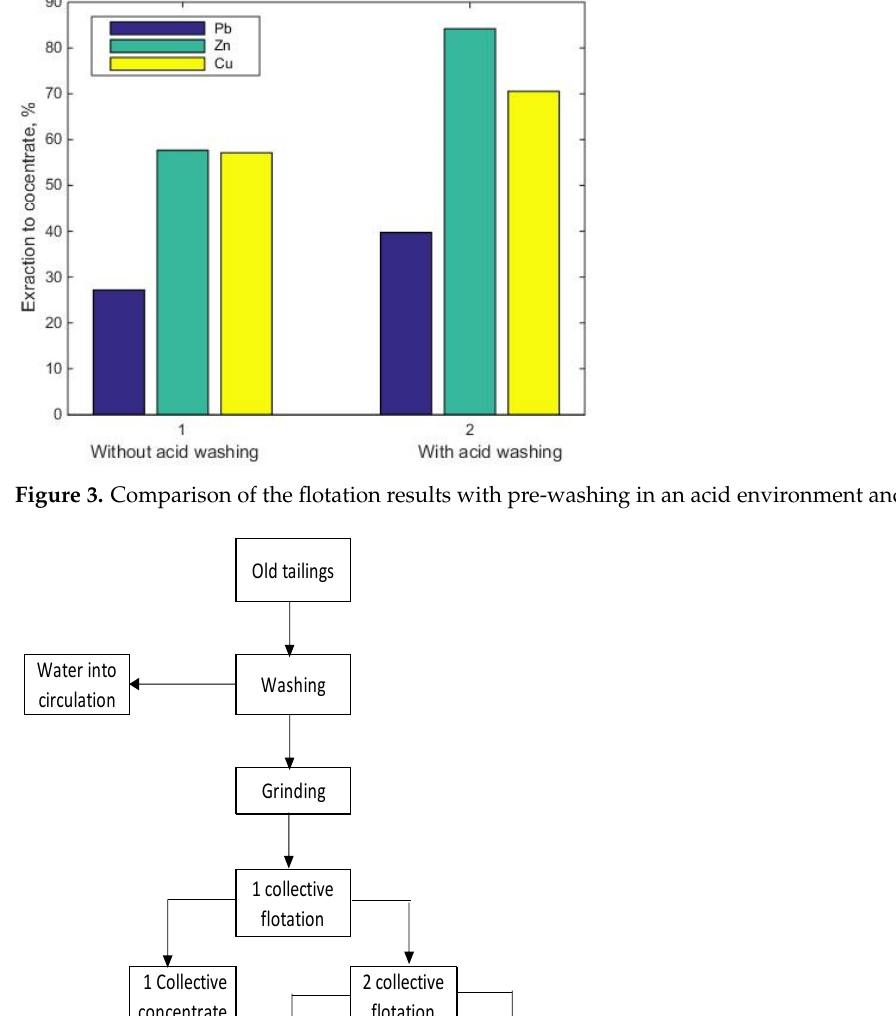
Figure 3. Comparison of the flotation results with pre-washing in an acid environment and with- out.